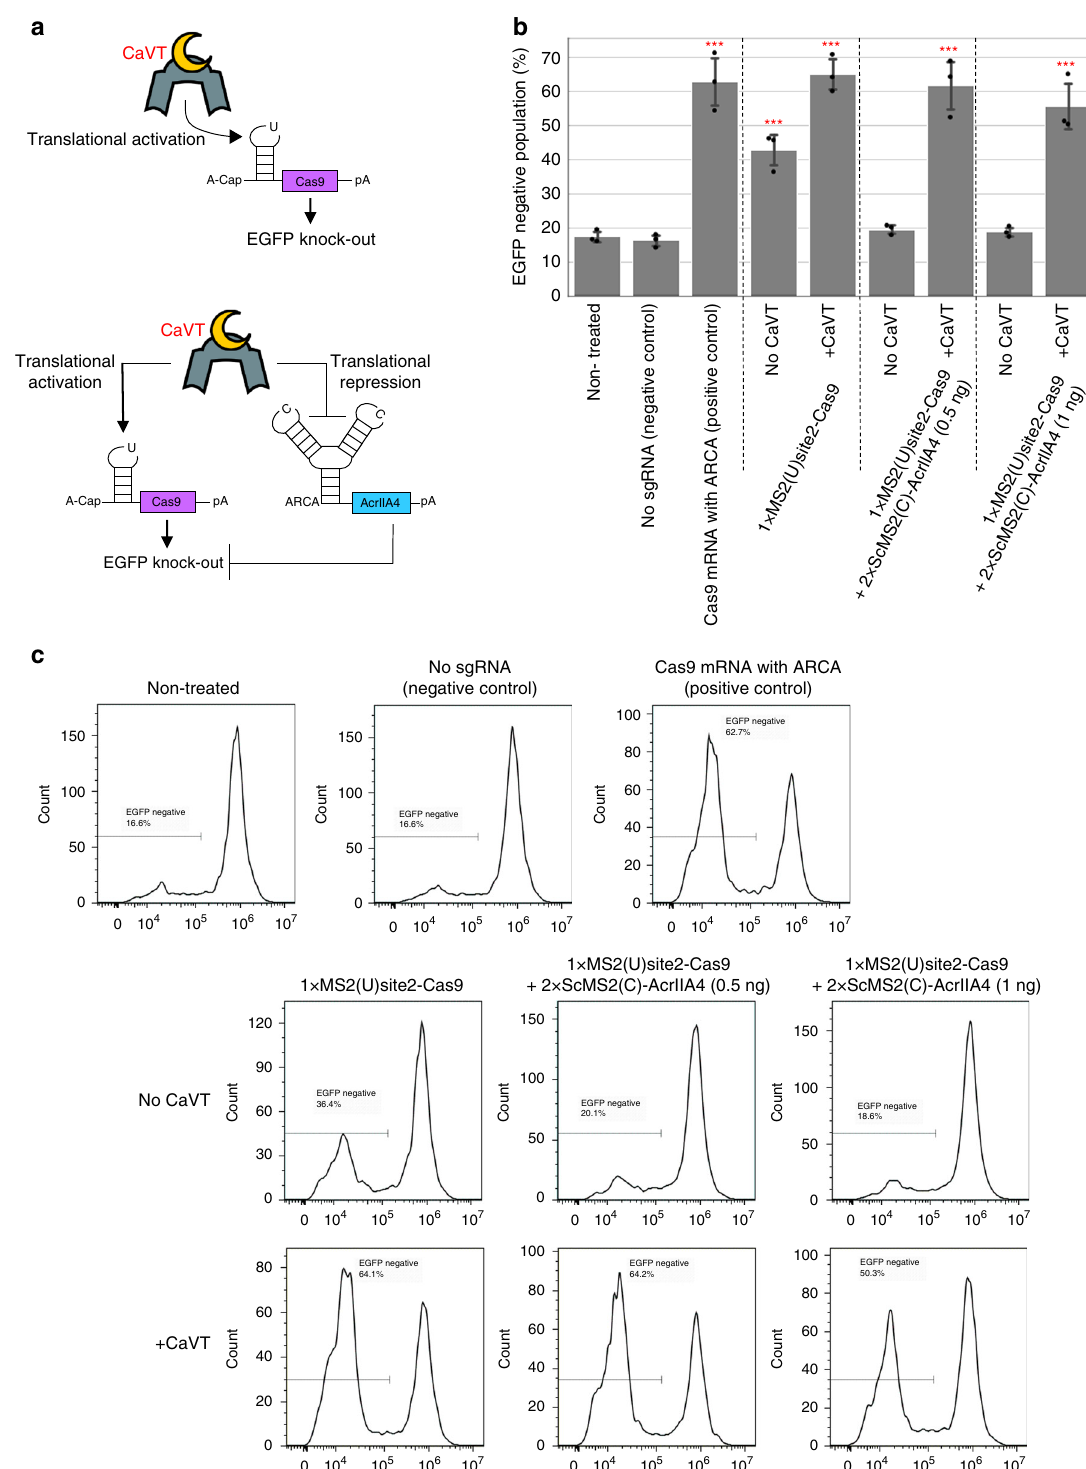
(FCV) mRNAs. As shown in Fig. 8d, e and Supplementary Fig. 14, a dose-dependent increase in the translation was observed. Finally, we captured time-lapse images to investigate the response time of the drug-regulatable CaVT. As early as 3 h after the dimerizer addition, an increase of hmAG1 fl uorescence was observed (Fig. 8f; Supplementary Videos 1 and 2). Together, these results indicate that we could achieve